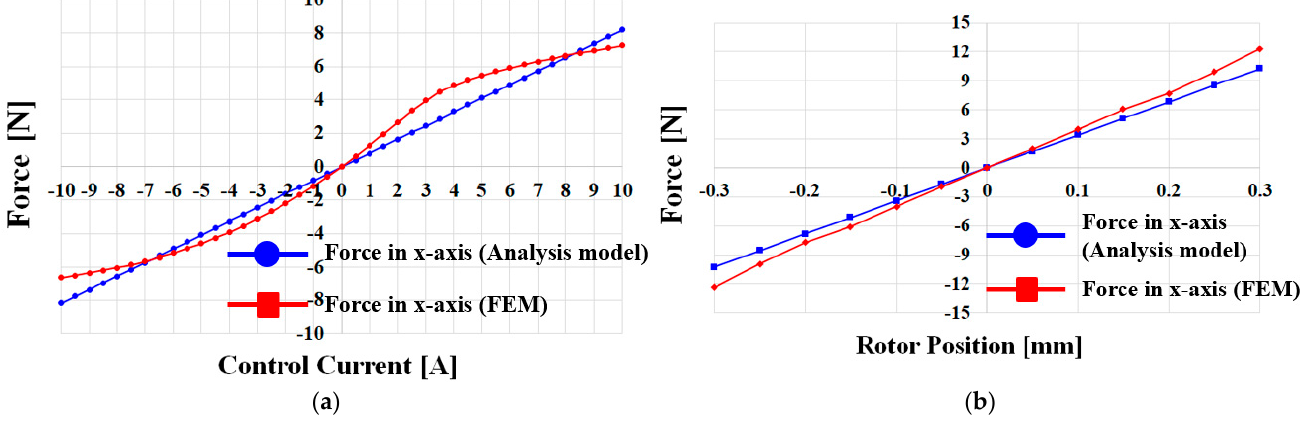
Figure 15. Force–current stiffness and the force in the HSTMB: ( a ) the force on the x -axis according to the control current and ( b ) the force on the x -axis according to the rotor position.